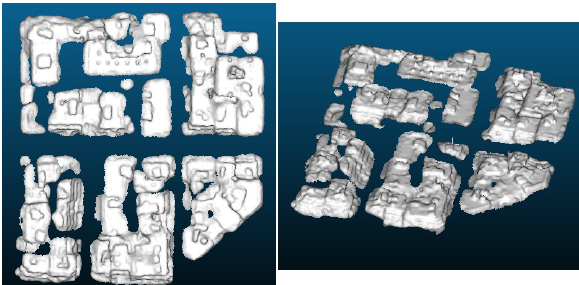
Figure 11. Screened Poisson Reconstruction of the tested area in